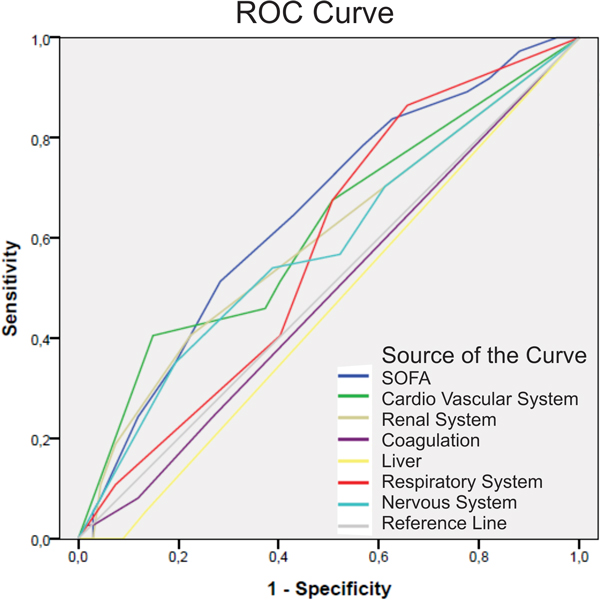
ROC curve for SOFA.